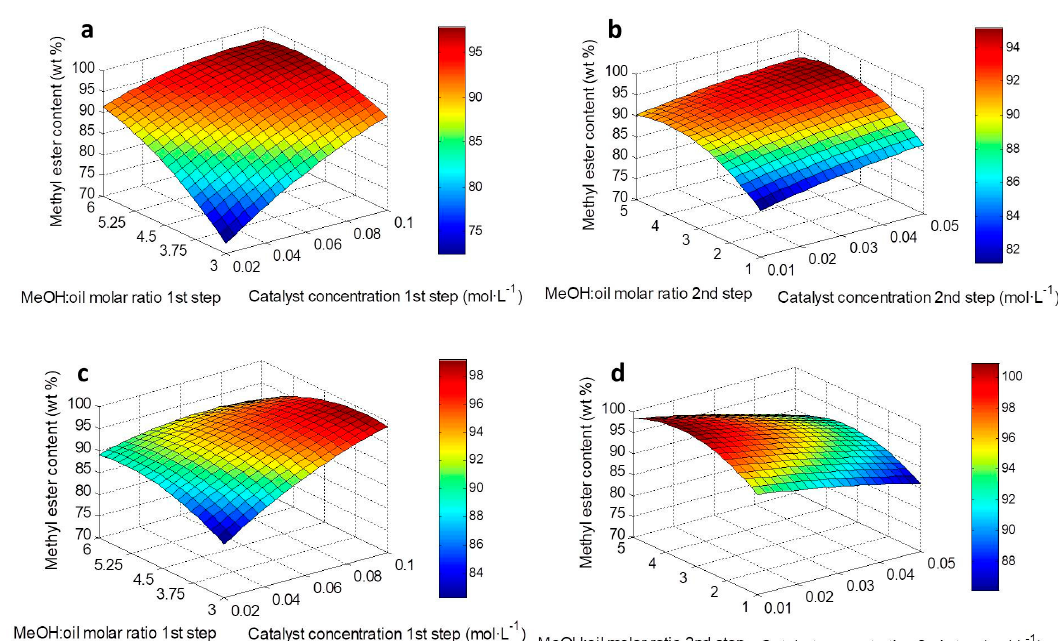
Figure 1. Response surface plots of ester content: ( a ) Catalyst concentration vs. MeOH/oil molar ratio